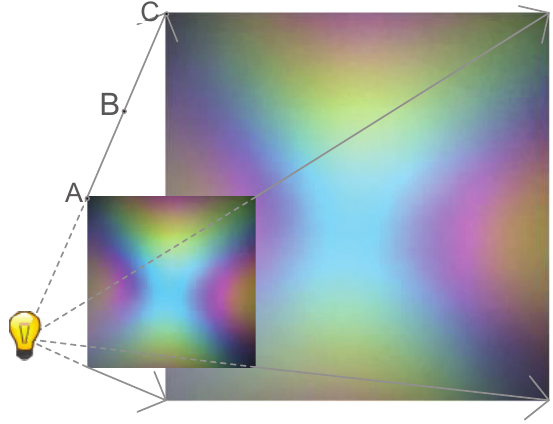
Figure 3. Illustration of fingerprint